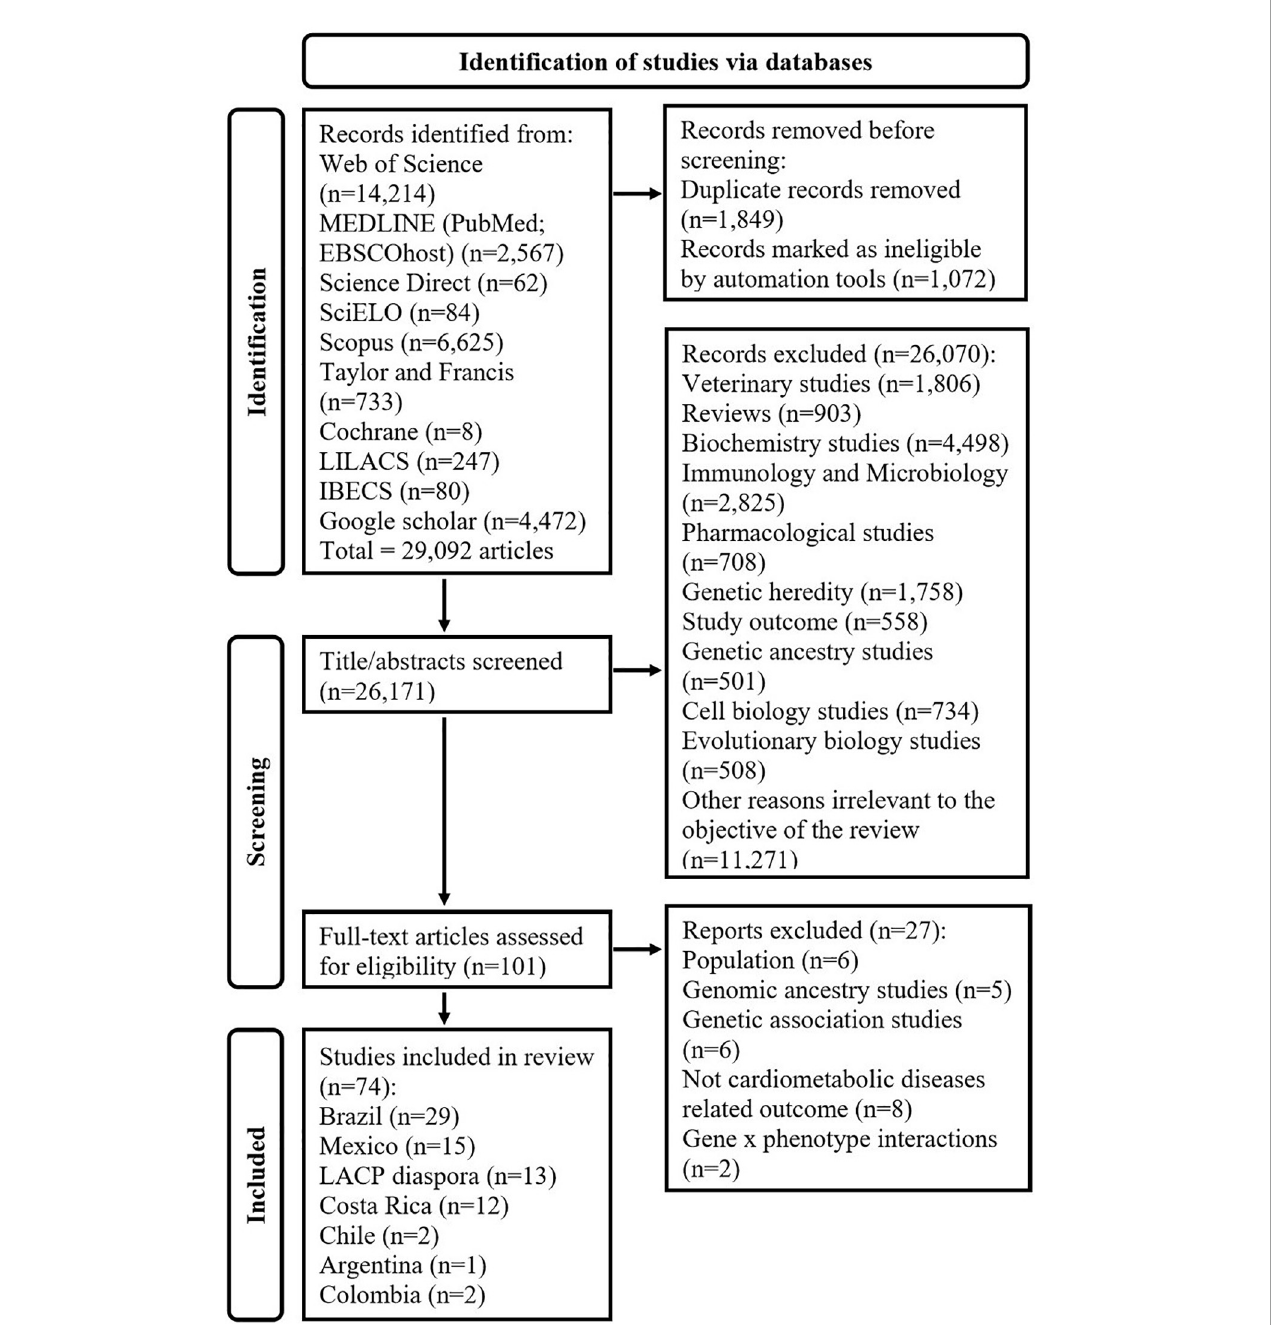
FIGURE5 Flow chart showing the exclusion criteria and selection of studies. Literature search was conducted in MEDLINE ( via PubMed and EBSCO Host), Web of Science, ScienceDirect, SciELO, SCOPUS, Taylor & Francis Online, Cochrane library, LILACS (Latin American and Caribbean Health Sciences Literature), IBECS, Google Scholar, and ERIC (Education Resources Information Center via EBSCO Host) search engines until the 25th of May